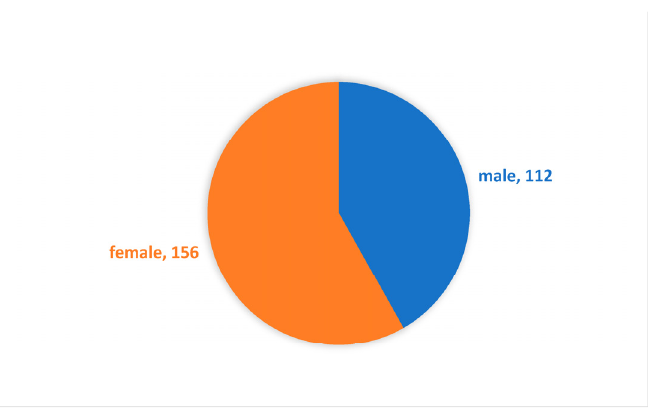
Figure 2. Distribution of gender (numbers in the figure represent an actual number of test subjects in each group).